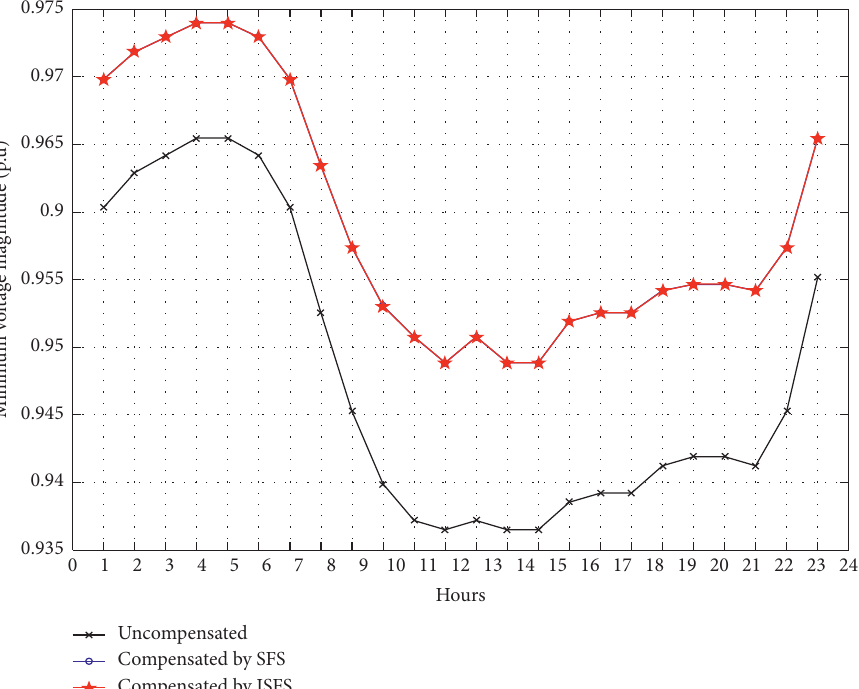
Figure 30: Minimum bus voltages of 152-bus network within 24-hour interval before and after compensation in scenario